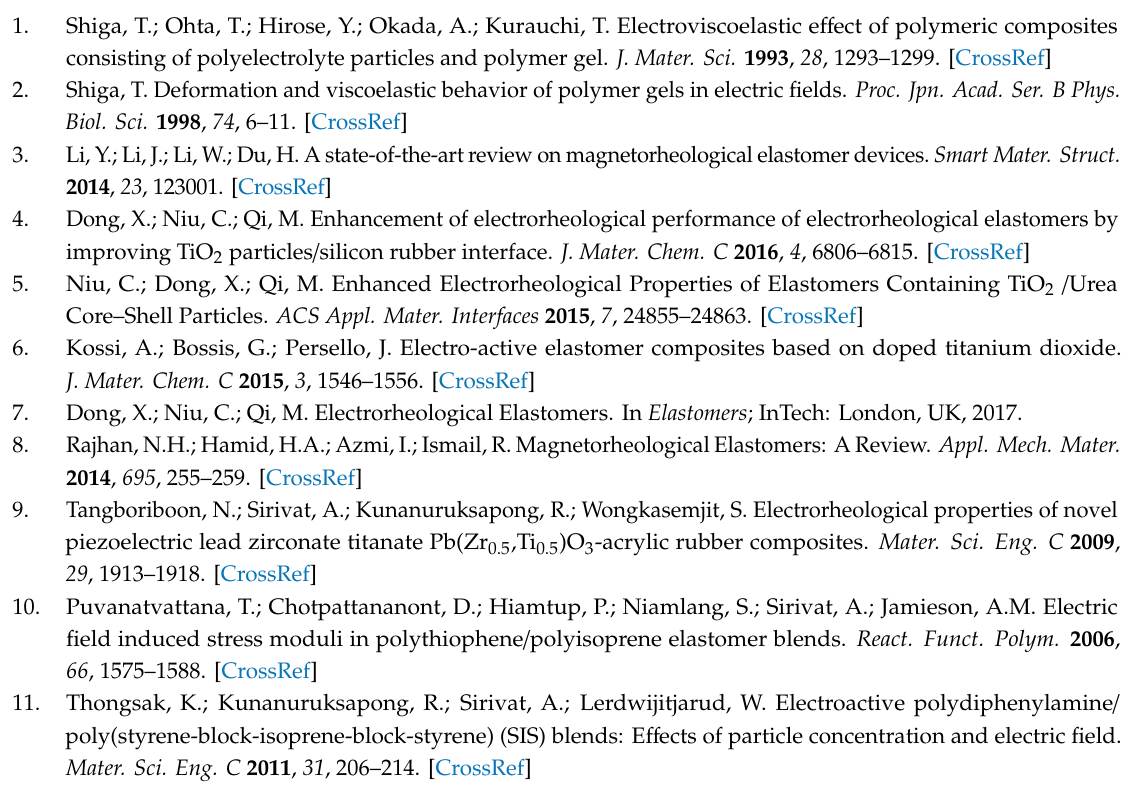
Figure S1: The appearance of α -MnO 2 suspension at 40 × magnification in uncured polydimethylsiloxane between the electrodes ( a ) in the absence and ( b ) in the presence of an electric field. The interelectrode gap was 1